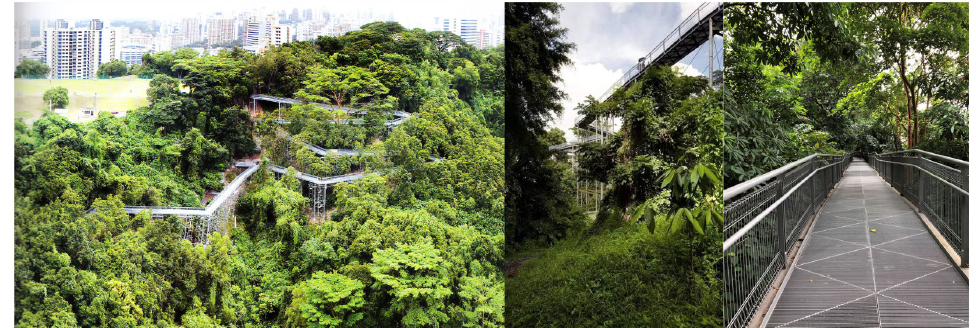
Figure A1. The treetop walkways in European countries built by die Erlebnis Akademie Ag (eak) of Germany (Source: